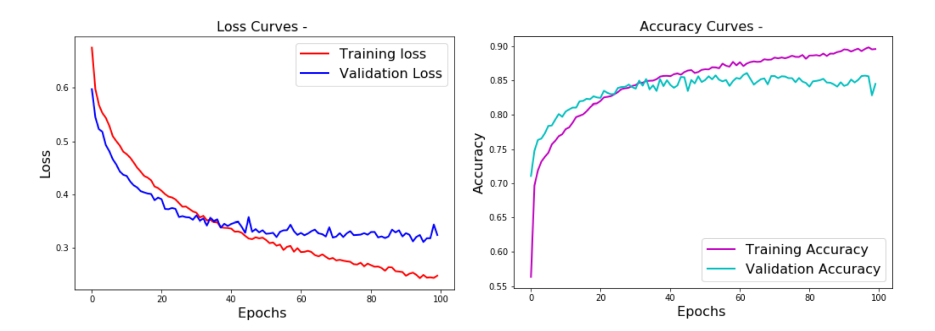
Figure 2. Training performance curves (loss on the left , accuracy on the right ) of the binary